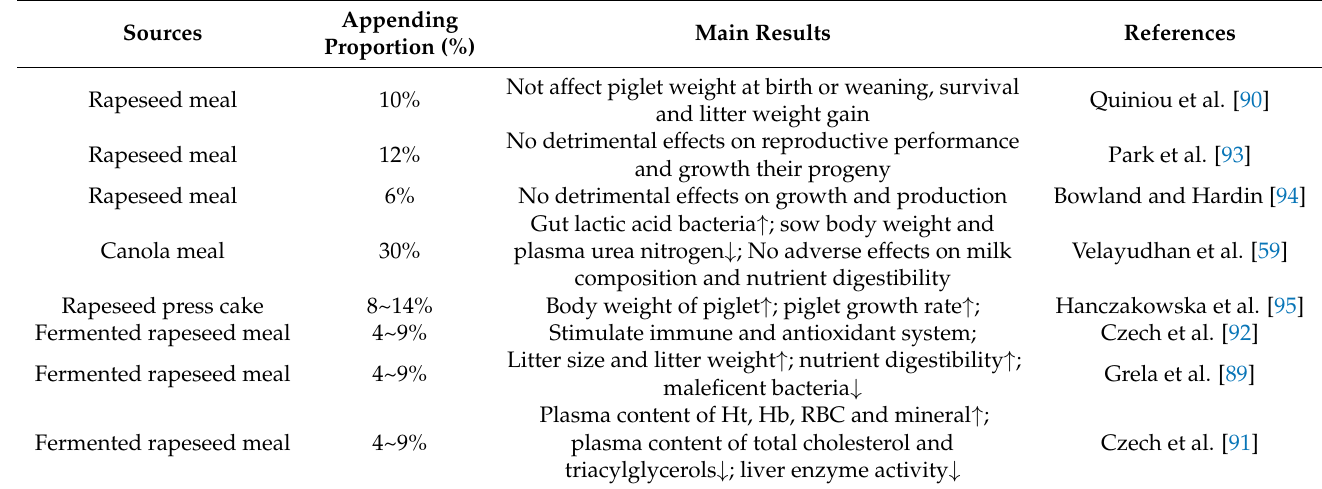
Table 5. The effects of rapeseed meal on reproduction performance of